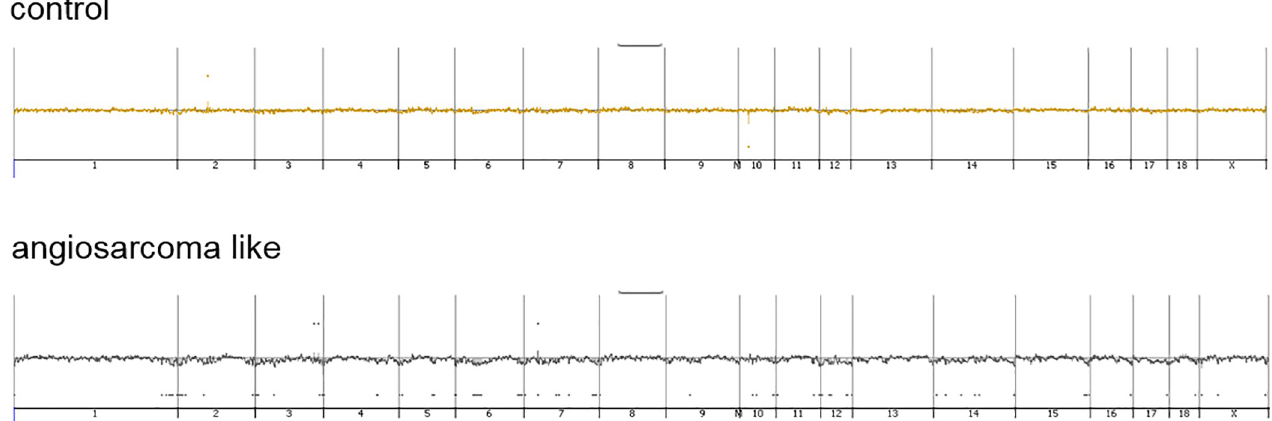
Fig 6. aCGH analysis of pig angiosarcoma. Representative aCGH plots of hepatic angiosarcoma (lower panel) and control tissue (upper panel). Chromosomal aberrations are shown along the chromosomes.